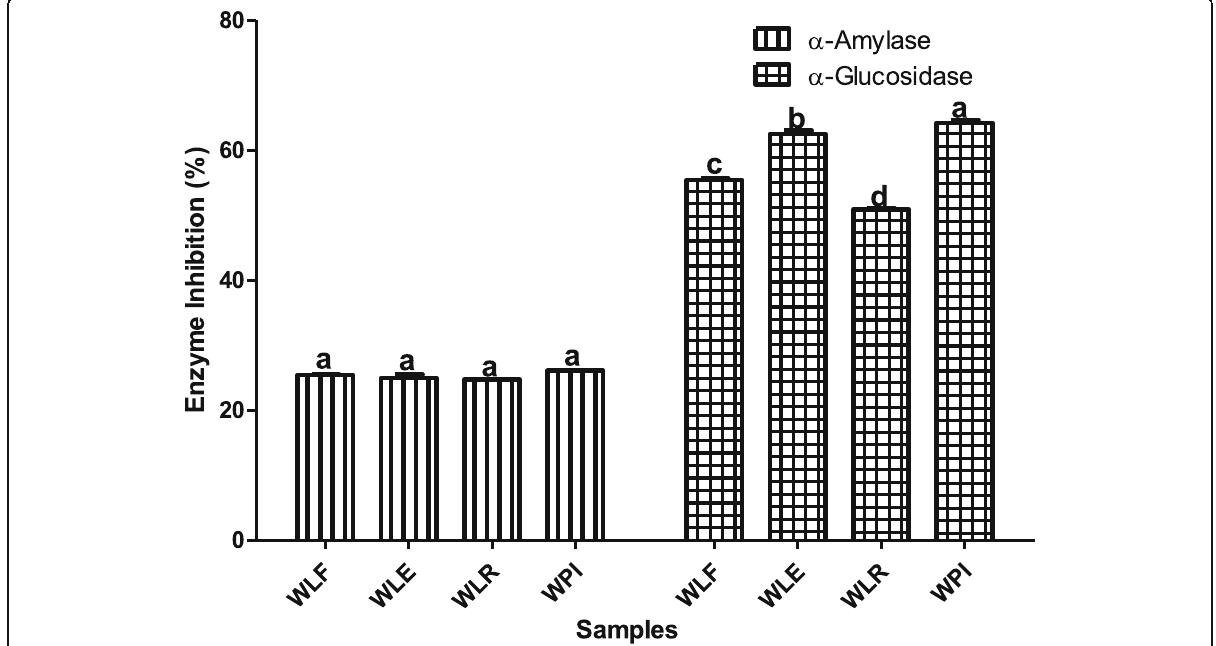
Fig. 1 α -amylase and α -glucosidase enzyme inhibitory activities of African wild lettuce leaf samples. Key: WLF; Whole wild lettuce powder, WLE;